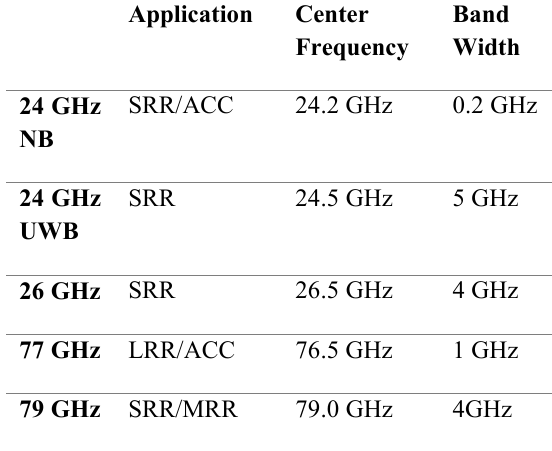
Table 1: Automotive radar applications summary